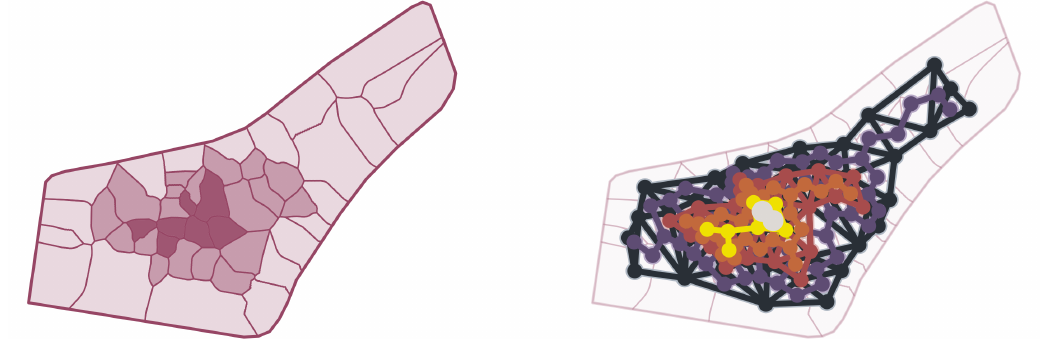
Figure 5. Weak dual graph sequences for Freetown street blocks ( a ) A street block in Freetown with inner parcels shaded (left), and its corresponding weak dual sequence (right; black → purple → red), of length 3 ( k = 3). ( b ) A more complex, and thus less accessible, Freetown block with multiple levels of inner parcels shaded (left), and its corresponding weak dual sequence (right; black → purple → red → orange → yellow → white), of length 6 ( k = 6). Due to the higher k -index, this block would be considered more “slum-like”.